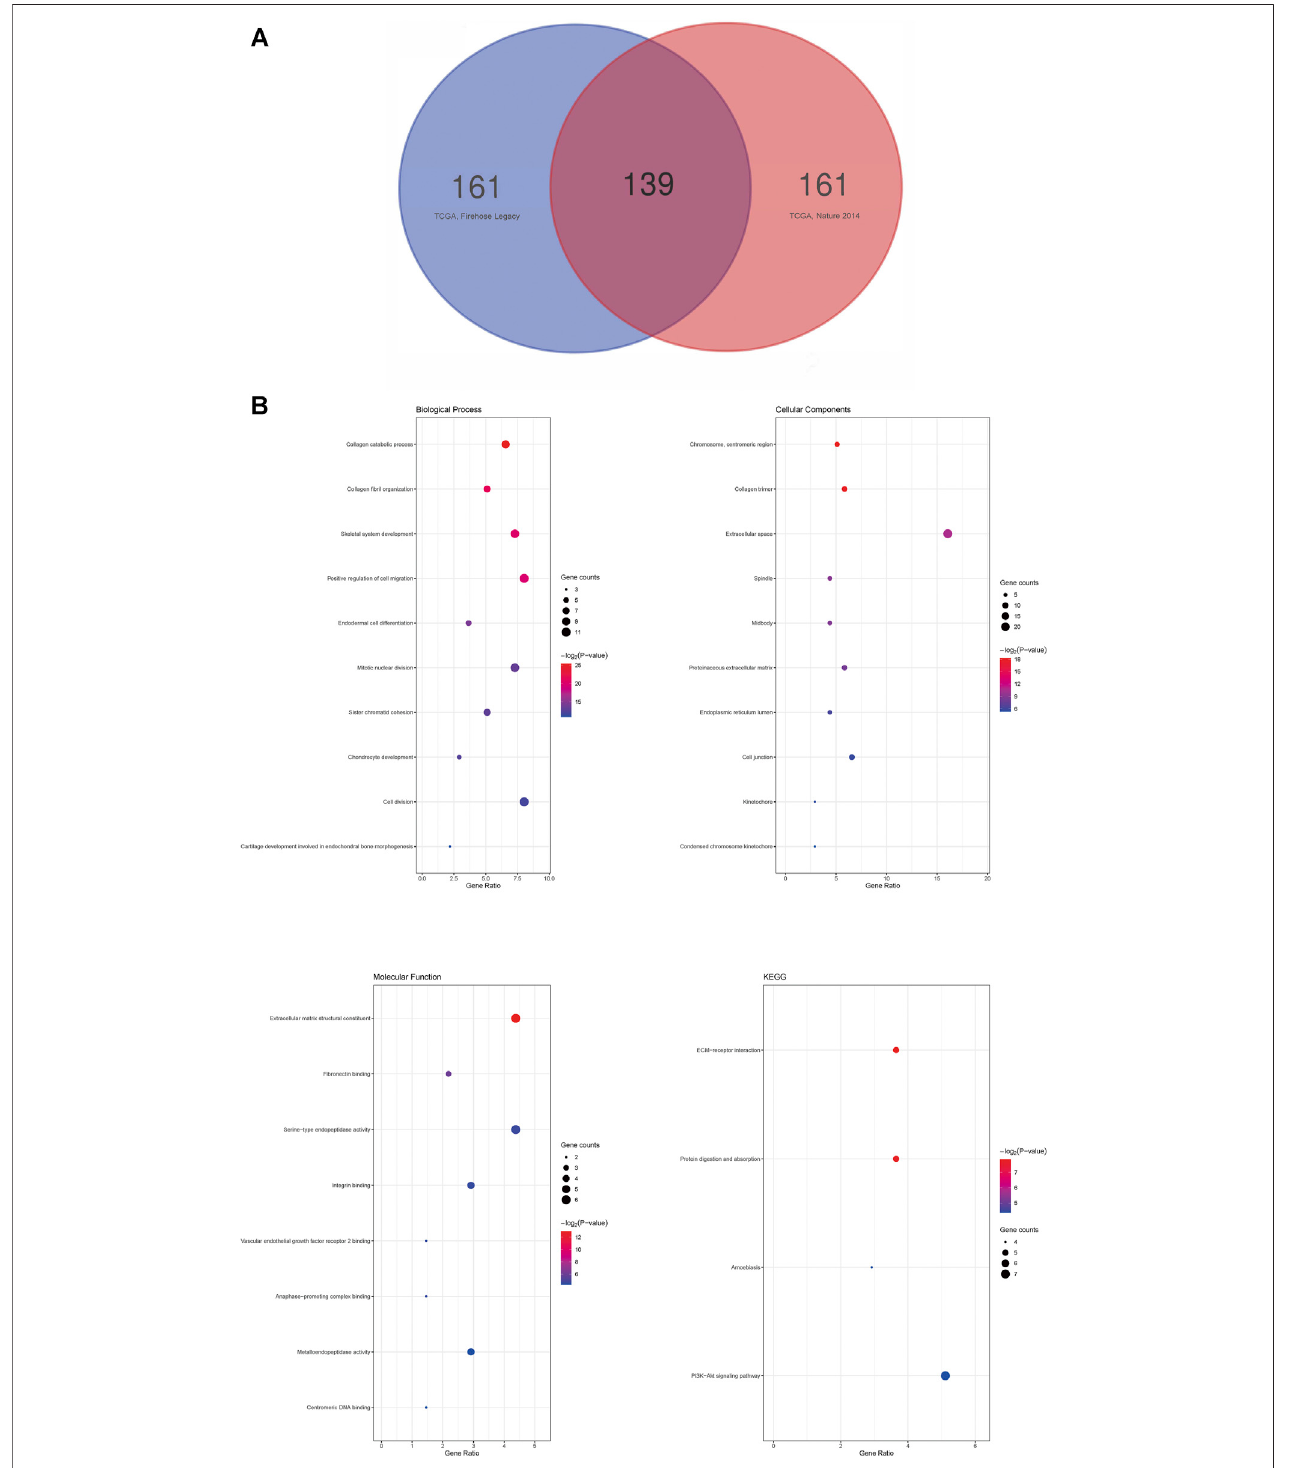
FIGURE7 | Enrichmentanalysisof correlated genes with SHOX2 in LUAD. (A) Venn diagram of SHOX2 correlated genes in LUAD. The 139signi fi cantly correlated geneswith SHOX2 appearedintwoTCGAresearchcohorts,FirehoseLegacy(586samples)andNature2014(230samples). (B) GOandKEGGanalysesof SHOX2 and thesigni fi cantlycorrelatedgenesbyDAVIDdatabase.Thenodesizerepresentsthegeneratio;thenodecolorrepresentsthe p -value.LUAD:lungadenocarcinoma;GO: Gene Ontology; KEGG: Kyoto Encyclopedia of Genes and Genomes.